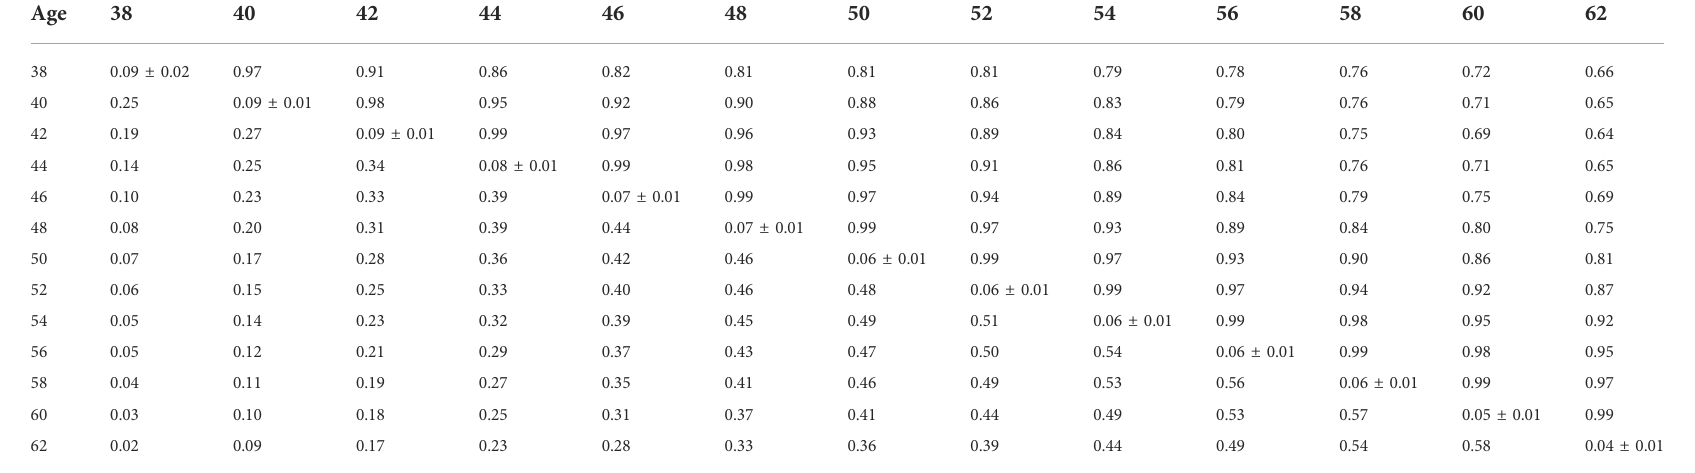
TABLE 5 Estimates of heritability (diagonal), phenotypic correlations (below diagonal), and genetic correlations (above diagonal) for fertility (FERT) using the pedigree random regression model. Age